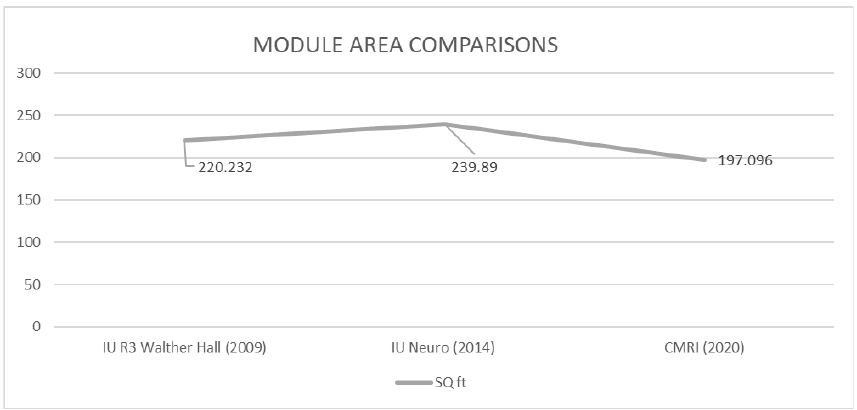
Figure 10 Lab module length and width size comparison across time.